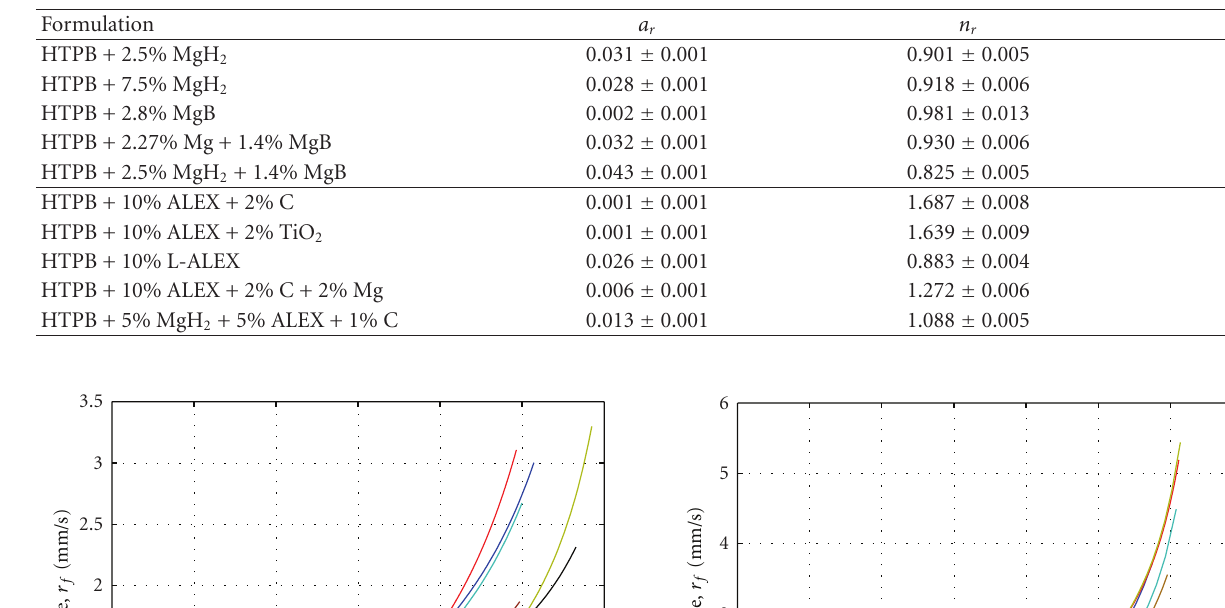
Table 6: Additivated formulations: coe ffi cients and uncertainties for constant power law approximation of the regression rate. For baseline data, see Figure 6.